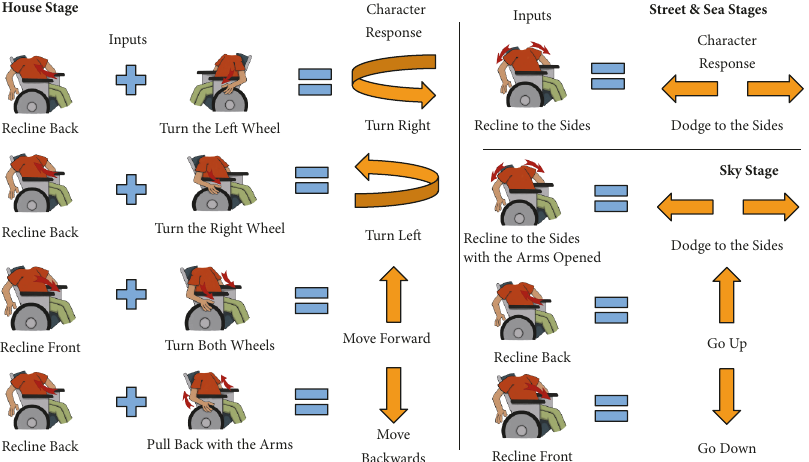
Figure 8: Relationship between body movements and the inputs in the game for controlling the character by NUI in the revised version of the game.